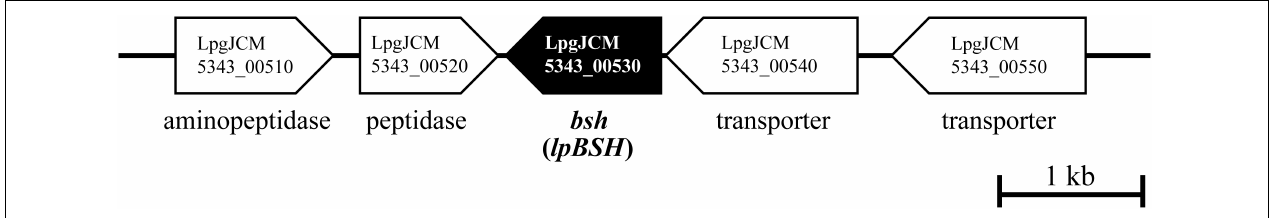
FIGURE 1 | Physical map of the predicted bile salt hydrolase gene on the genome sequence of L. paragasseri JCM 5343 T (accession number: AP018549). The scale bar indicates a 1 kb length of nucleotide. A putative bile salt hydrolase gene ( lpBSH ) and other ORFs are represented by filled and open symbols, respectively. Locus tag ID and brief annotation are